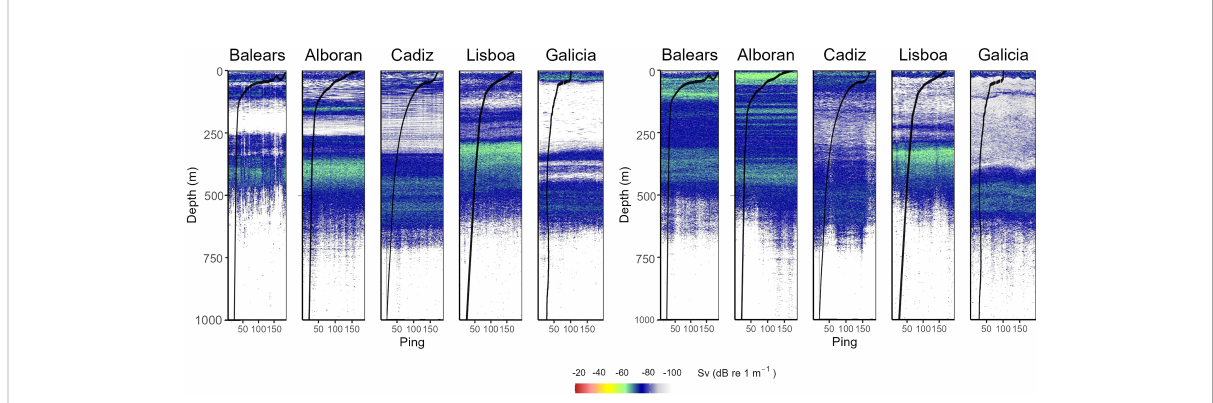
FIGURE 7 Typical zonal scattering layer distributions observed using the hull-mounted 38 kHz echosounder. The colour scale is echo intensity (mean volume backscattering strength, S v , dB re 1 m -1 ). Left panels are daytime observations, and right panels are night-time. Ping repetition interval was 2 seconds. At the c. 2.5 knots vessel speed that these observations were made (between net hauls), the 200 pings shown equate to about 500 m distance travelled. The overlaid black curves represent the temperature pro fi les for simultaneous CTD casts (as shown in Figure